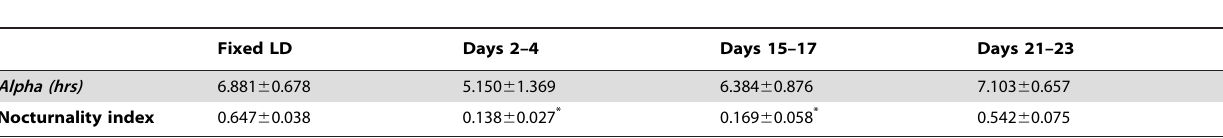
Table 2. Circadian analysis of hamsters maintained in a static light:dark (LD) cycle and during days 2–4, 15–17, and 21–23 of the jet lag paradigm.